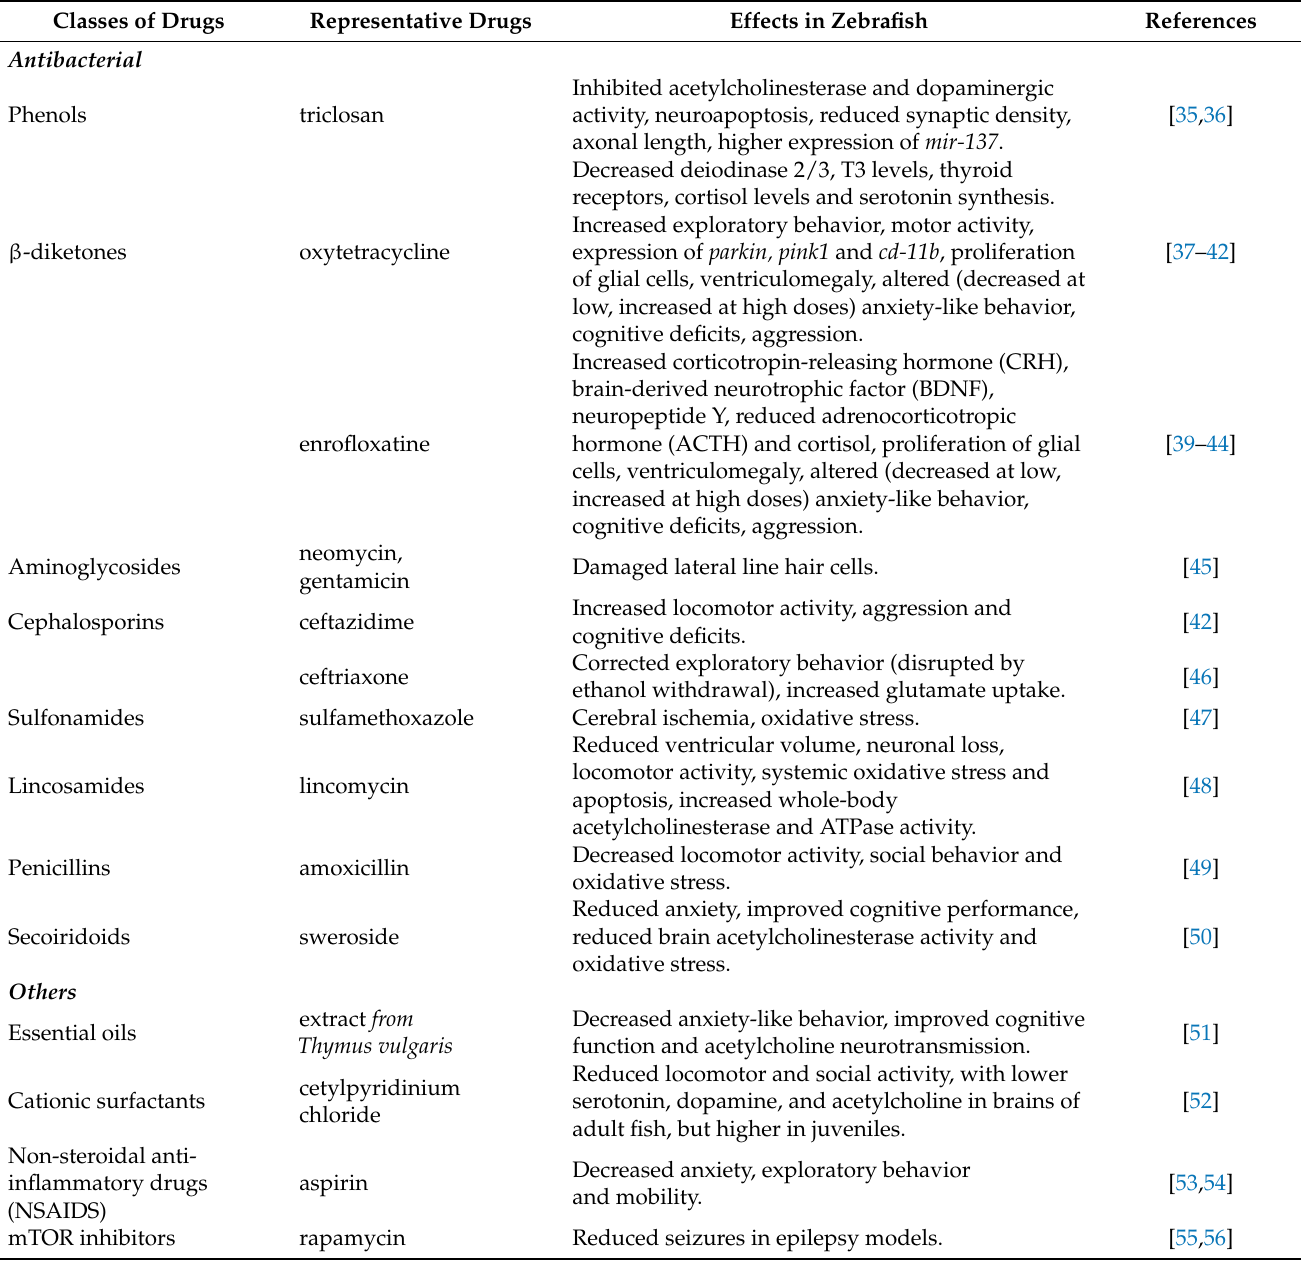
Table 1. Selected examples of CNS effects of antimicrobials on